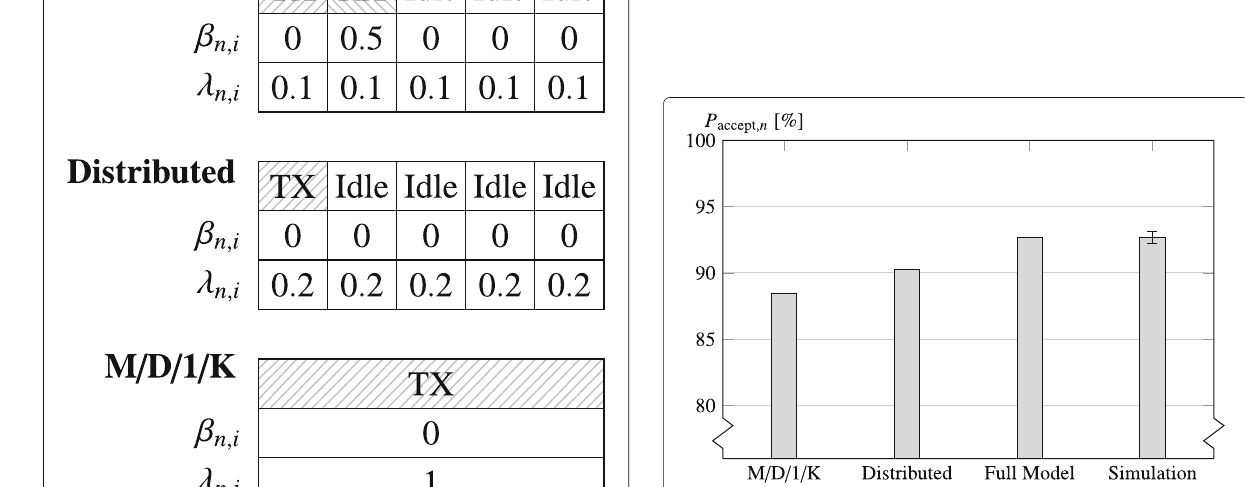
Fig. 7 Comparing the full presented model with a simulation and simpler models: An M/D/1/K model and a model that considers the TX and Idle slots, but distributes the reception over all